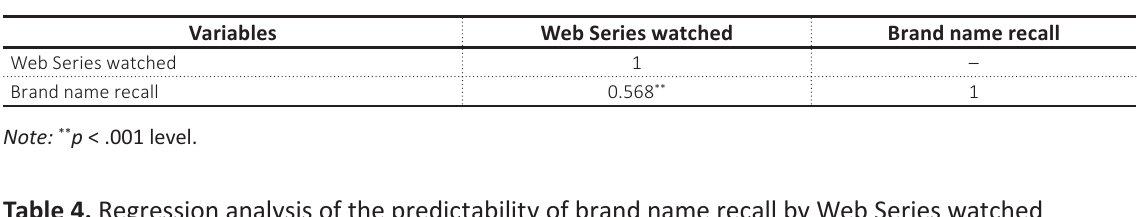
Table 3. Correlations between the number of Web Series watched and the number of brand name recall